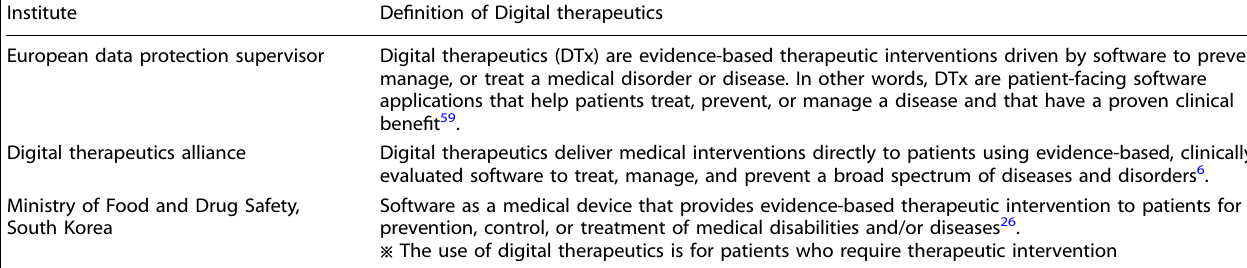
Table 1. De fi nition of digital therapeutics by country and